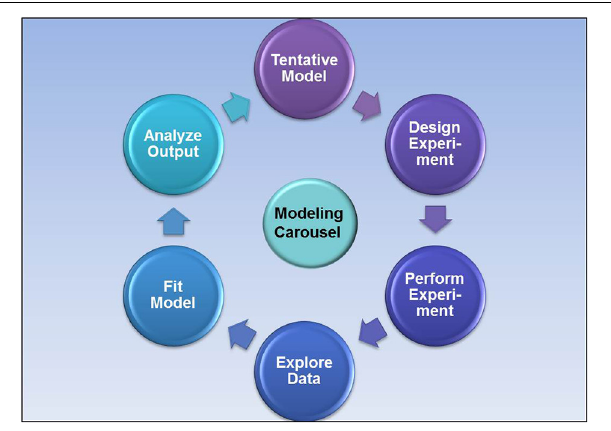
FIGURE 1 | The iterative process of PK/PD modeling in drug discovery.